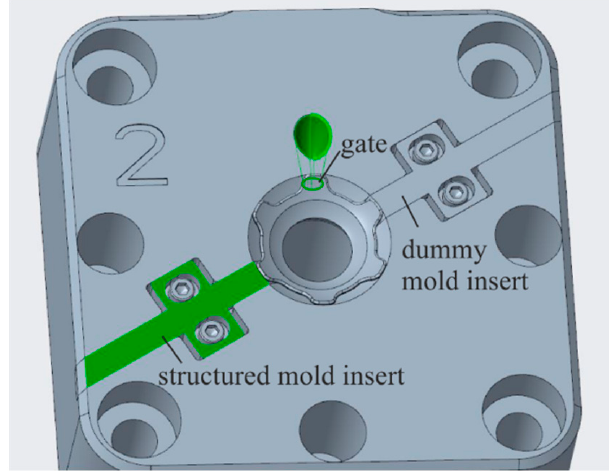
Figure 2. Mold design of the injection mold with mold insert.